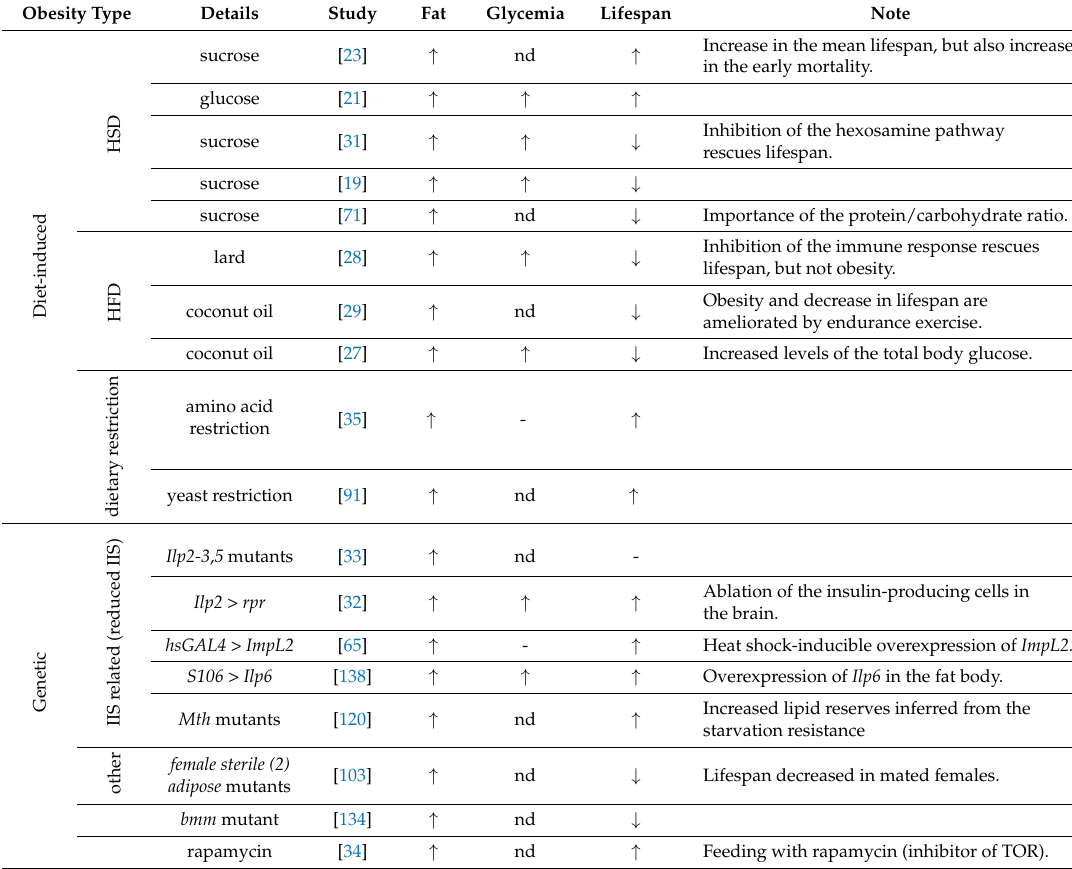
Table 1. Examples of obesity-causing manipulations and their effects on the lifespan of